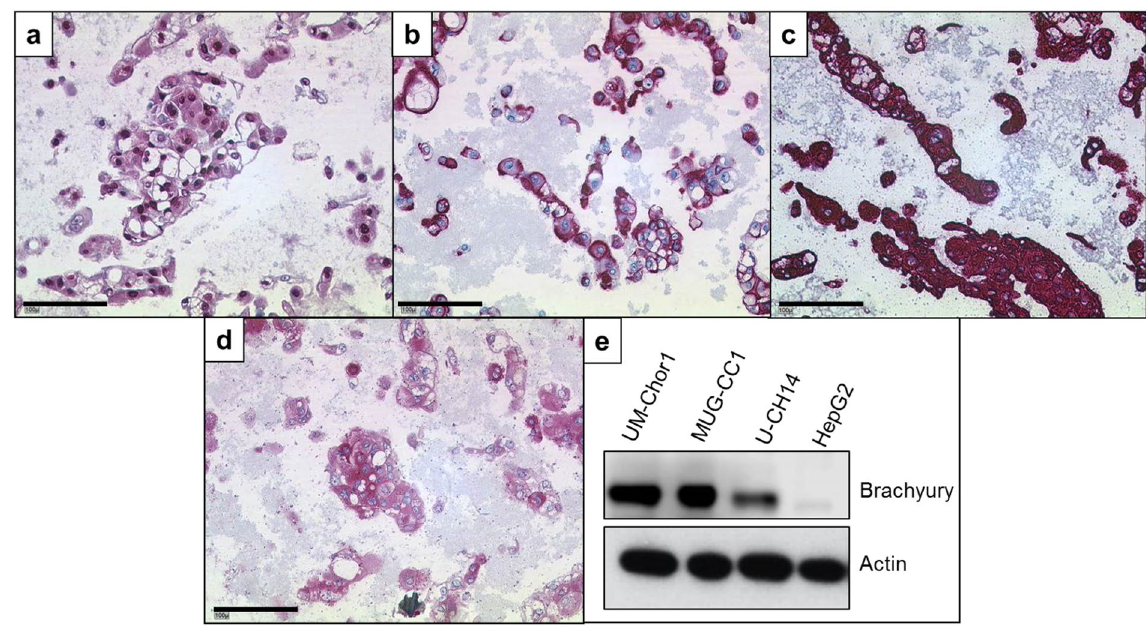
Figure 2. Immunocytochemistry and western blot analysis of U-CH14. The cells are strongly positive for brachyury ( a ), vimentin ( b ), cytokeratin (AE1/AE3) ( c ), and S-100-protein ( d ). ( e ) Western blot confirmation of the brachyury expression in the three clivus chordoma cell lines (UM-Chor1, MUG-CC1, and U-CH14). HepG2 served as a negative control. Lines indicate 100 µ m ( a–d ).